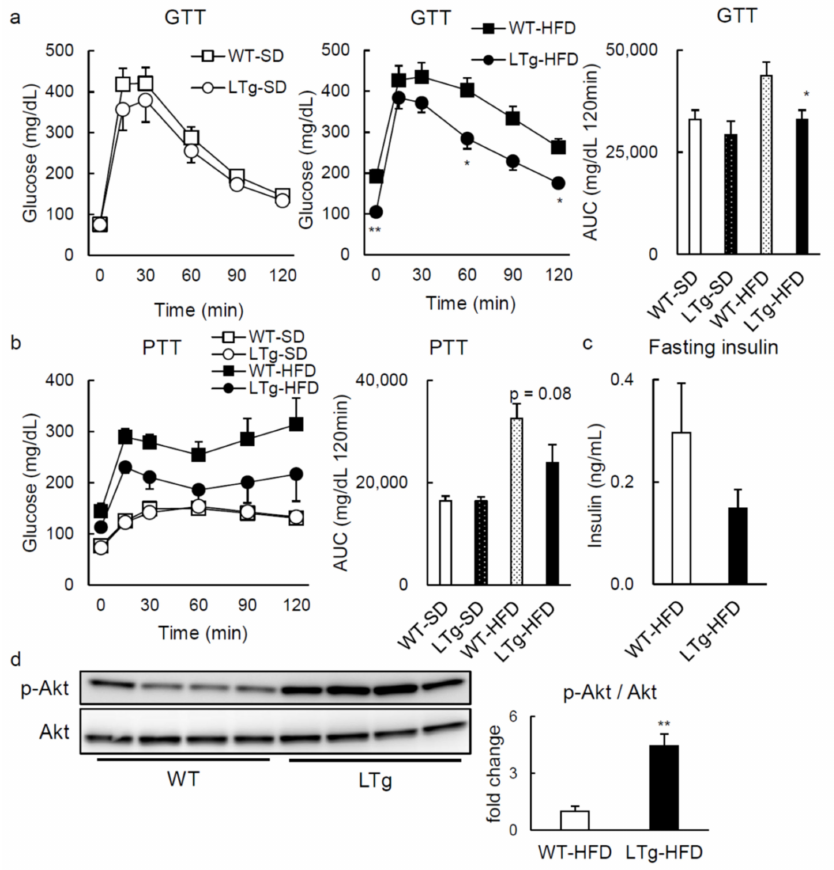
Figure 2. LTg mice under feeding HFD improved insulin resistance. ( a ) Blood glucose levels during glucose tolerance test (GTT) (2 g/kg for SD and 1 g/kg for HFD) and the total area under the curve (AUC) in WT/LTg mice under feeding SD or HFD after overnight fast (14 h) (n = 8–11 mice per group). Values are shown as the mean ± SEM; * p -value < 0.05 and ** p -value < 0.01. Two-way repeated measures analysis of variances was used for GTT in SD or HFD, and t test was used for AUC in HFD. ( b ) Pyruvate tolerance test (PTT) (2 g/kg) and the total AUC in WT/LTg mice under feeding SD or HFD after overnight fast (14 h) (n = 7–11 mice per group). Values are shown as the mean ± SEM. Two-way repeated measures analysis of variances was used for PTT in SD or HFD, and t test was used for AUC in HFD. ( c ) Blood insulin levels in HFD mice after overnight fast (14 h) (n = 4 mice per group). Values are shown as the mean ± SEM. ( d ) Western blotting and quantification of phosphorylated and total Akt in the liver of the WT/LTg mice under HFD feeding after overnight fast (14 h) (n = 4 per group). Values are shown as the mean ± SEM; ** p -value < 0.01 ( t